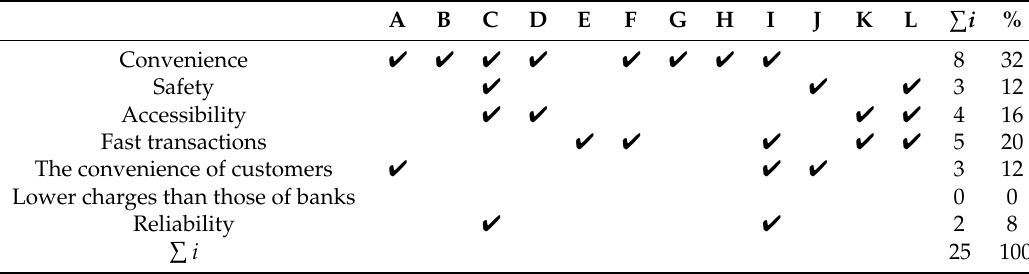
Table 7. Motivations for electing to use Mobile Money Services to make and receive payments.